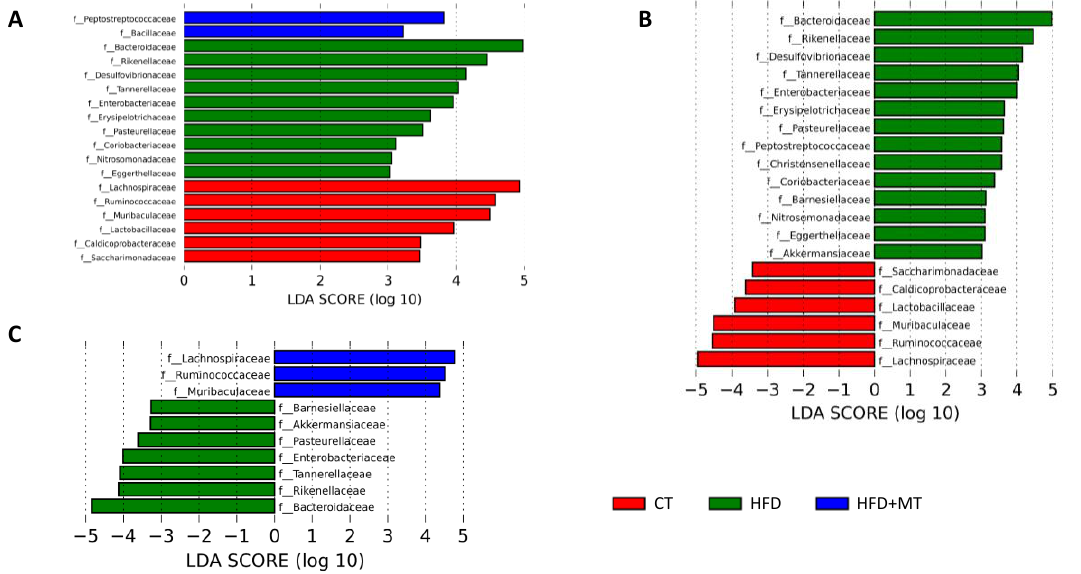
Figure 4. LEfSe analysis showing taxonomic differential abundance at family level in feces from control animals fed a normal chow (CT) and animals fed a high fat diet (HFD) treated with vehicle or with the mitochondrial antioxidant MitoTempo (MT; 0.7mg/Kg/day i.p). ( A ) Significantly different families among CT, HFD and HFD+MT groups. ( B ) Significantly enriched and depleted families between CT and HFD groups. ( C ) Significantly enriched and depleted families between HFD and HFD + MT groups. The length of the horizontal bars represents the LDA score (effect size). p < 0.05; LDA score > 3.0.